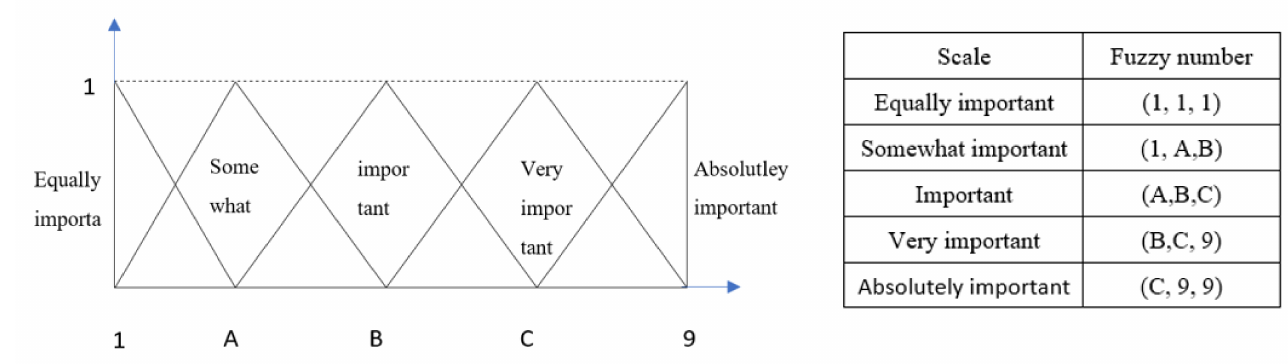
Figure 6. Converting the respondents’ semantic values into fuzzy